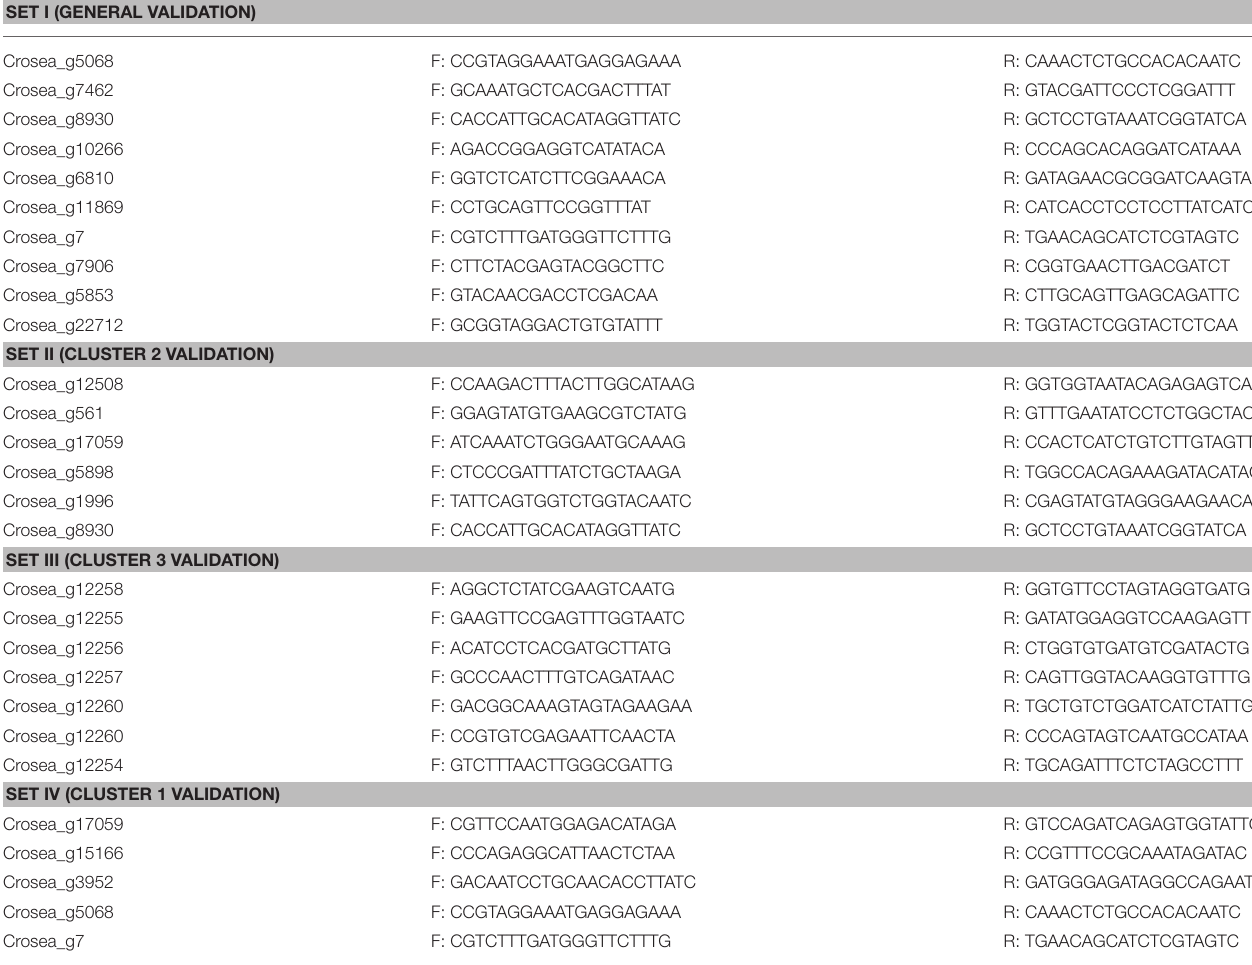
TABLE 1 | Primers used in this